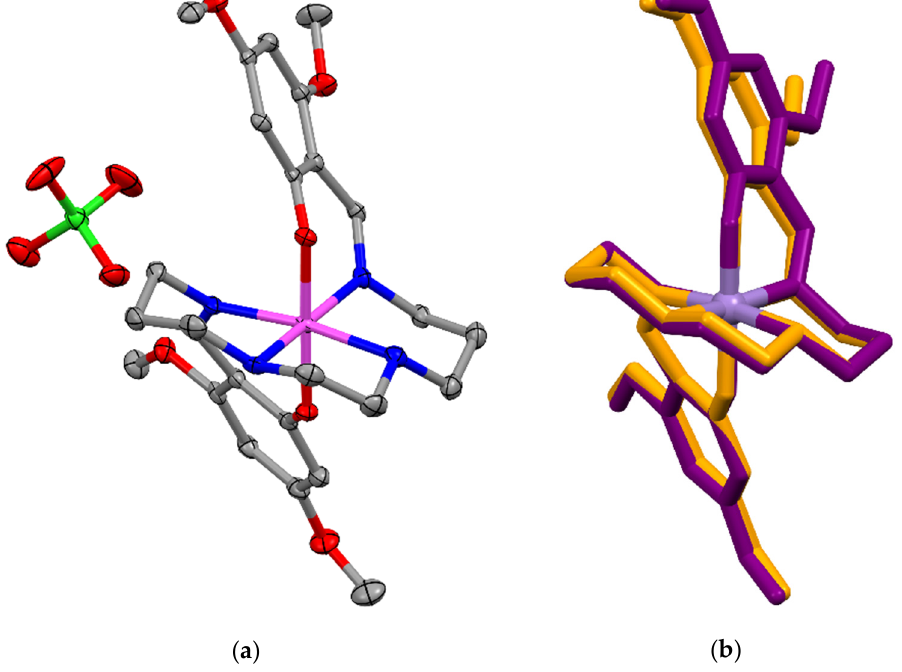
Figure 4. Asymmetric unit of complex ( 1 ), [Mn(4,6-diOMe-sal 2 323)]ClO 4 · 0.5H 2 O ( a ); and the struc- tural overlap of the cationic species, [Mn(4,6-diOMe-sal 2 323)] + , of complex ( 1 ) [Mn(4,6-diOMe- sal 2 323)]ClO 4 · 0.5H 2 O, (orange), and complex ( 5 ) [Mn(4,6-diOMe-sal 2 323)]Cl · C 2 H 5 OH (purple) at 100 K ( b ). Interstitial solvent molecules and hydrogen atoms omitted for